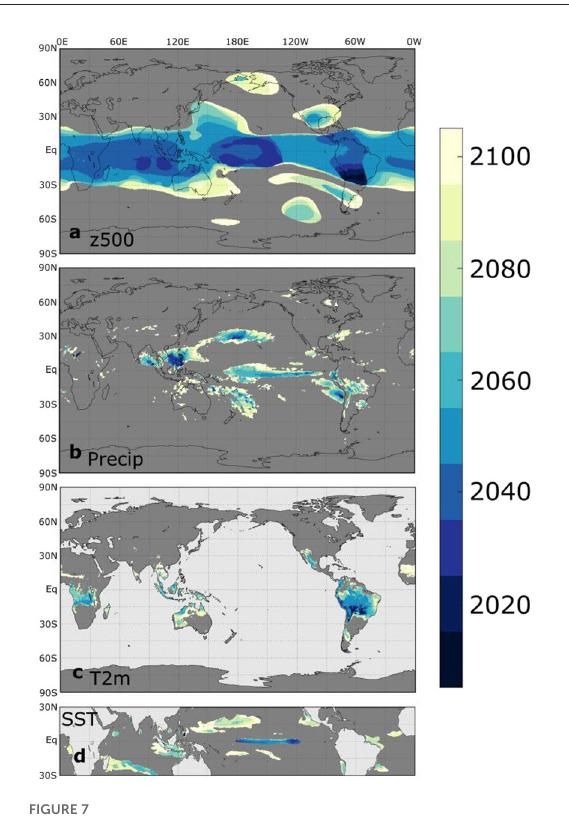
FIGURE7 DJF El Niño teleconnection change time of emergence (ToE), defined as the time when the SSP5-8.5 SPEAR ensemble mean 30-yr composite changes relative to 1951–1980 first exceed one ensemble standard deviation and remain outside the ensemble standard deviation through 2100. Dark gray regions indicate that the signal does not emerge before 2100. The ToE is shown for (a) z500, (b) precipitation, (c) T2m, and (d) SST.